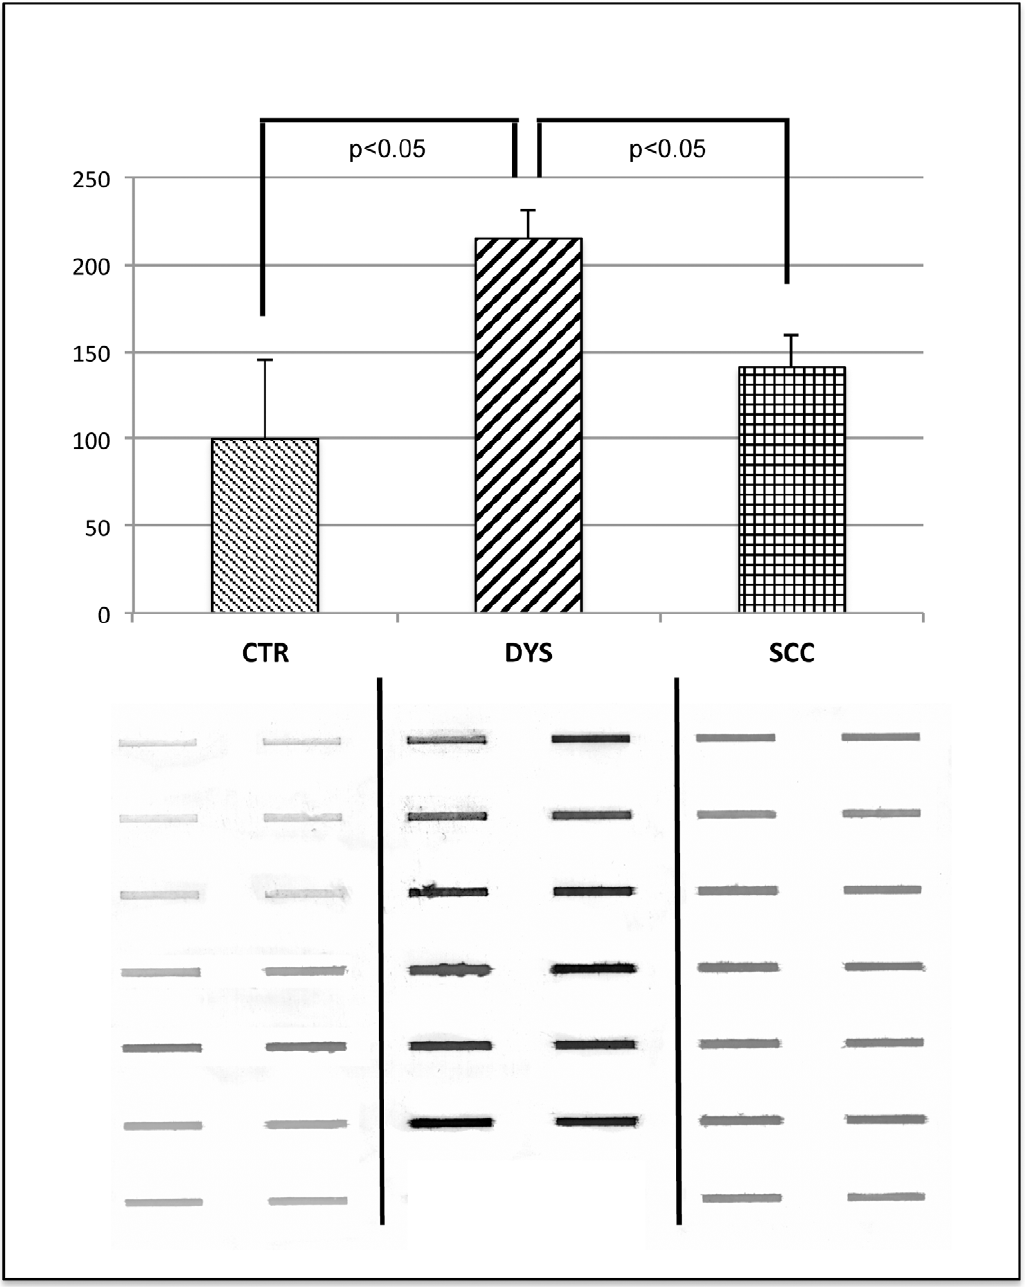
Figure 3. Total protein oxidation. Top: Quantification of levels of protein carbonyls in CTR, DYS and SCC cervical tissues. Samples were probed with anti-DNP protein adducts polyclonal antibody as described in Material and Methods . Densitometric values shown are given as percentage of the control group, set as 100%. Data are expressed as mean 6 SEM. p , 0.05 versus control (Student’s t -test). Bottom: Protein carbonyl slot- blots from CTR, DYS and SCC samples.